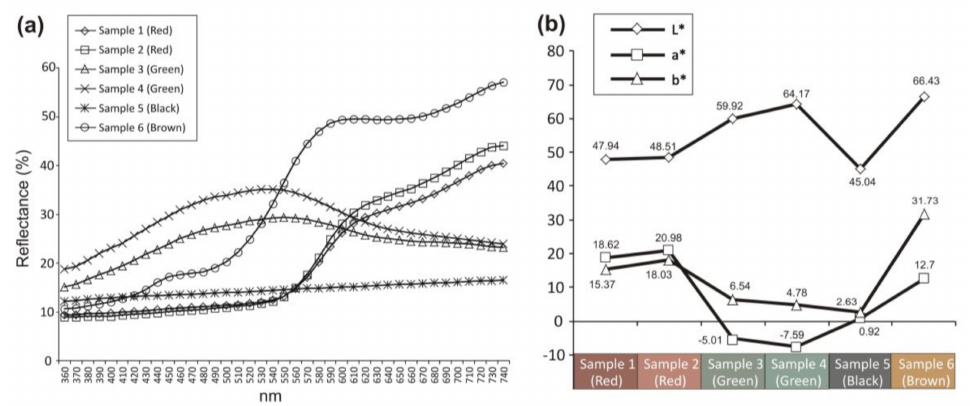
Figure 2. ( a ) Reflectance curves of the painted surface of the samples; ( b ) CIE-L*a*b* colorimetric coordinates of the painted surface of the samples